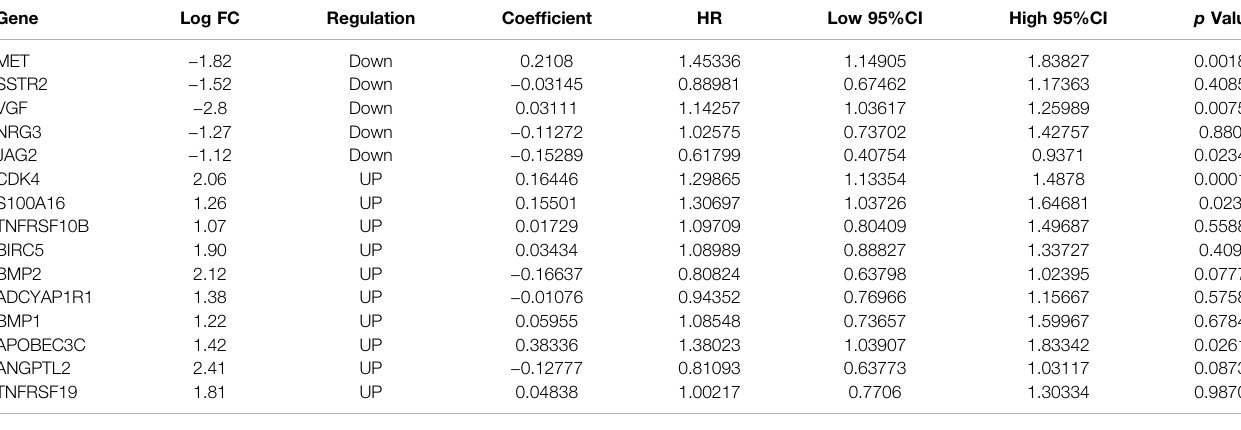
TABLE 3 | Univariate and multivariate analyses using the Cox proportional hazard model. HR, hazard ratio; CI, con fi dence interval. Overall survival Univariate analysis Multivariate analysis HR 95%CI p -value HR 95%CI p -value Entire TCGA Set Risk Score (high vs.